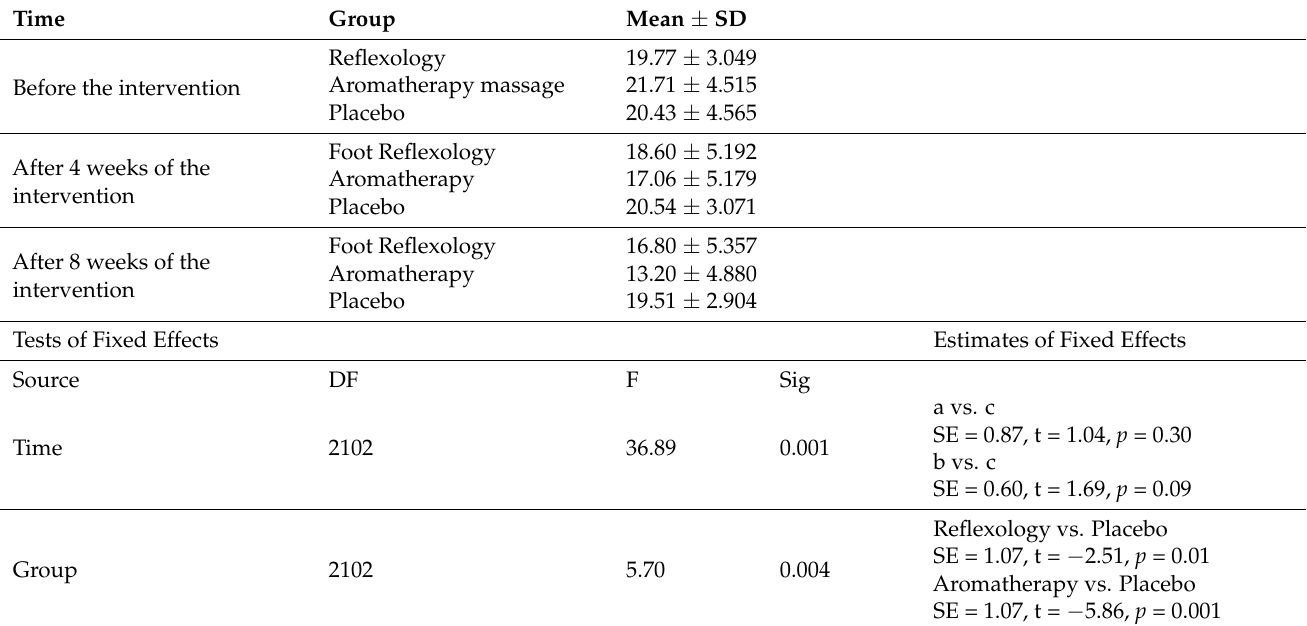
Table 2. Comparison of the mean scores of the severity of RLS at different time intervals between the